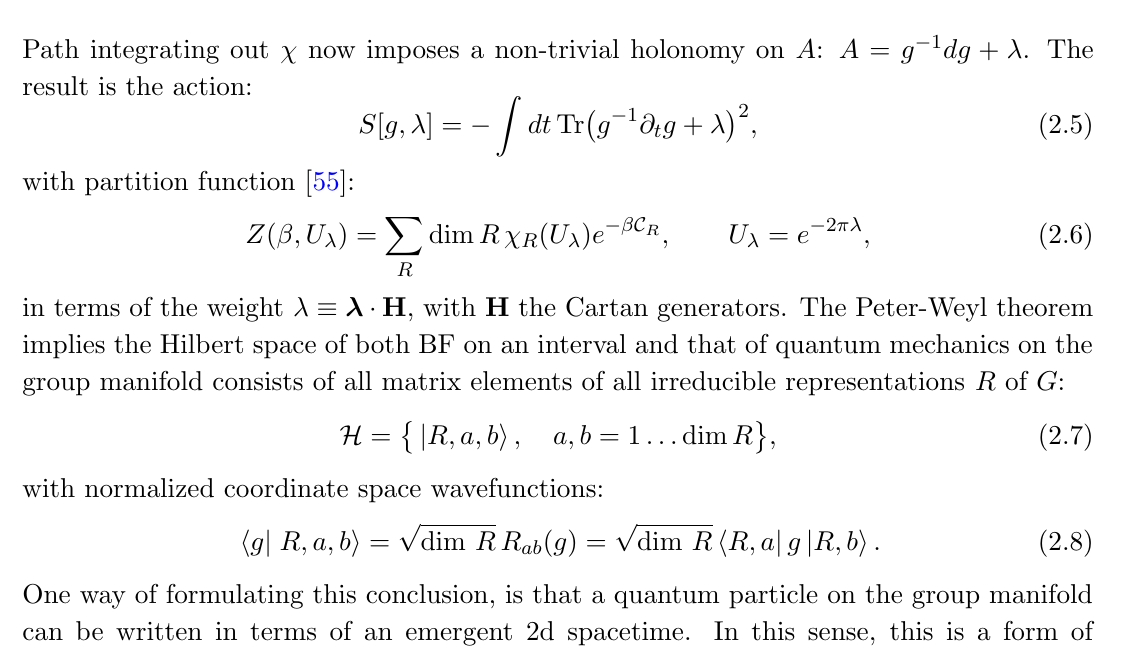
Figure 1 . Left: defect channel slicing of the amplitude where gh of the amplitude. Right: circular slicing connecting the inner boundary and the